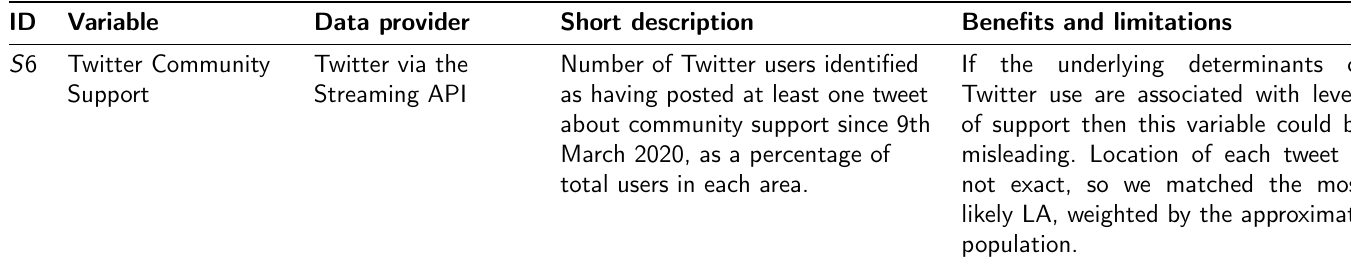
Table 6: Summary description of variables included in the reported support on social media